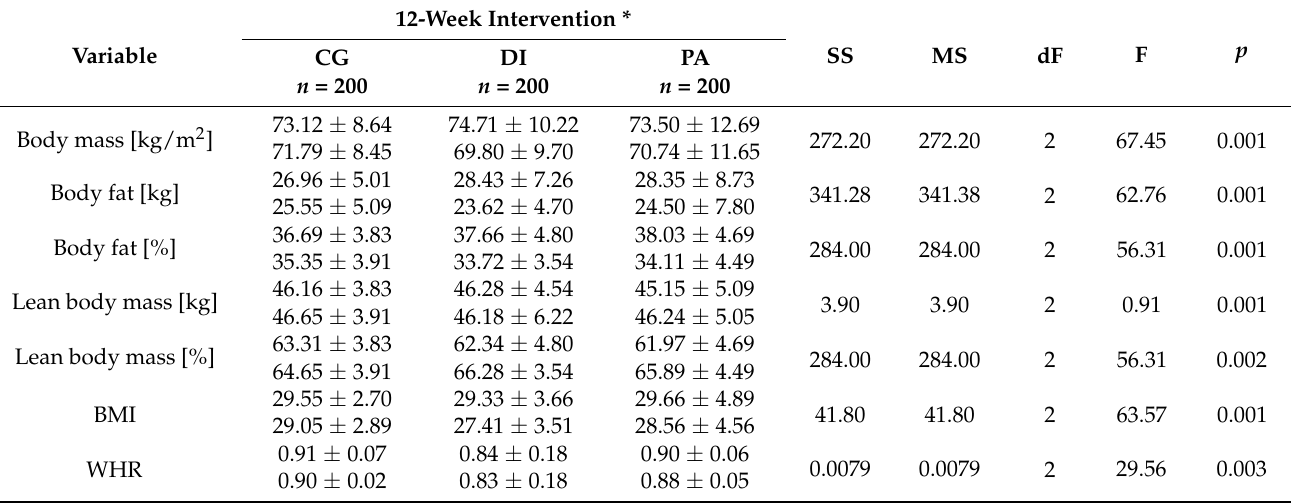
Table 1. Anthropometric indicators—differences between groups ( n = 600).